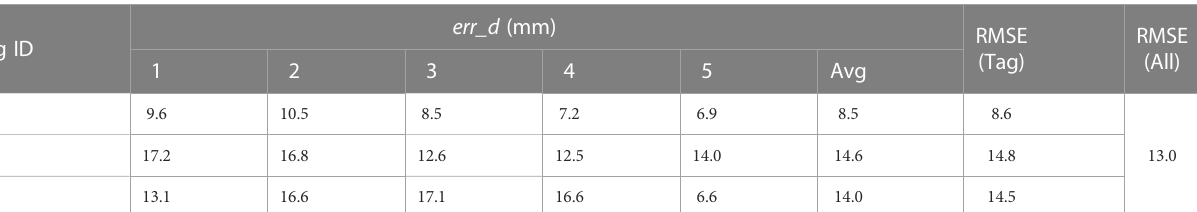
TABLE 1 Positioning accuracy of the ATI navigation